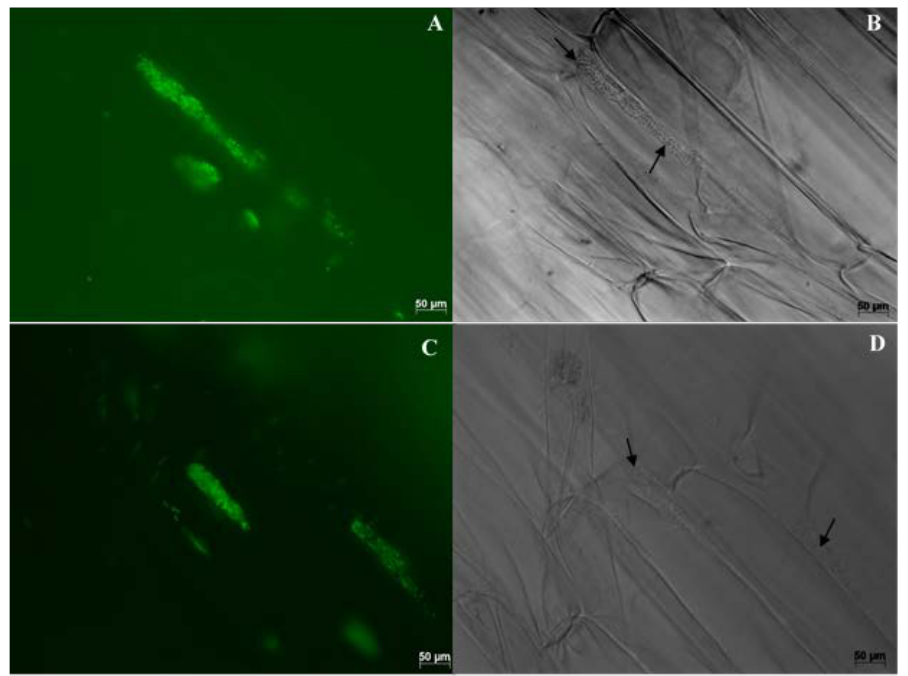
Figure 4. Maize (hybrid 29B17) radicle roots were colonized by WP5 gfp and visualized under 630× magnification. Images on the left ( A , C ) were taken with the GFP filter, and images on the right ( B , D ) were taken without the GFP filter. Microcolonies of WP5 gfp were observed along the plant cell wall areas between two adjacent cells.